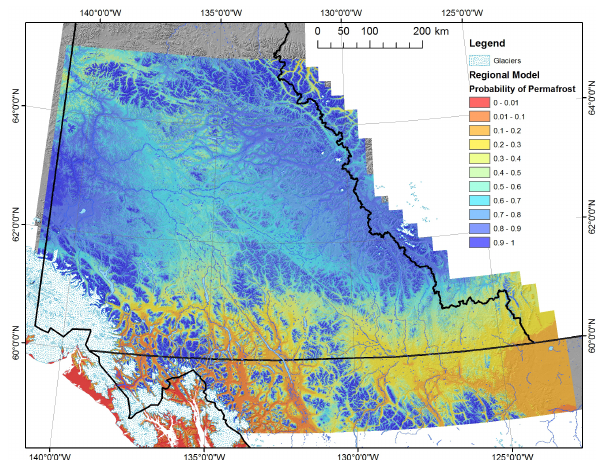
Fig. 2. Regional model permafrost probability map for present- day conditions (1971-2000). Permafrost underlies 58% of the unglaciated territory (Bonnaventure et al.,